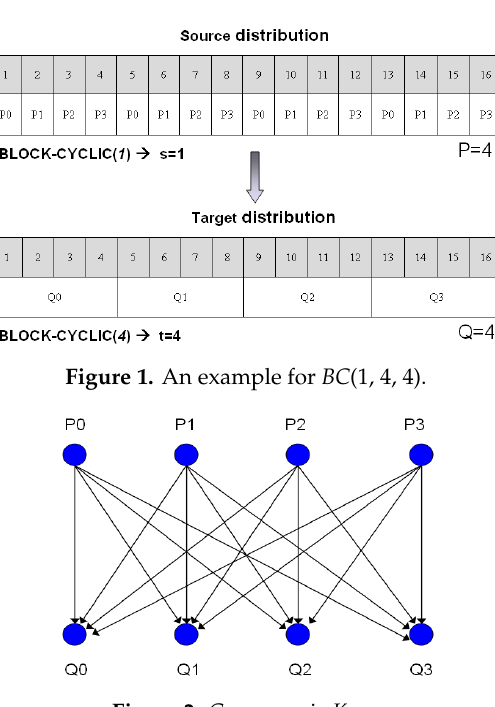
Figure 2. G BC (1, 4, 4) is K 4, 4 .